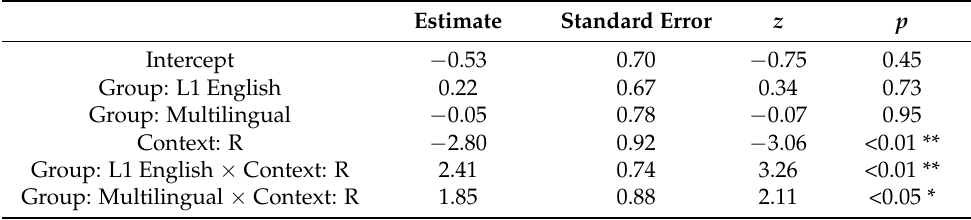
Table 4. Generalized linear model testing the effect of language group by context on the preference for Adj–N responses (formula: Adj–N ~ Group × Context + (1|Participant) +